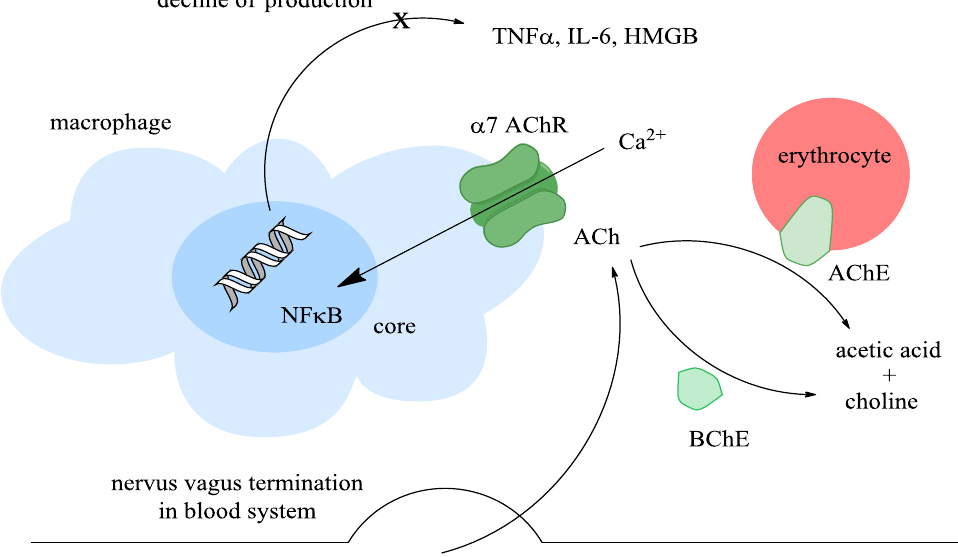
Figure 1. Principle of the cholinergic anti-inflammatory pathway; abbreviations: ACh-acetylcholine; AChE-acetylcholinesterase; BChE-butyrylcholinesterase; HMGB-high mobility group box; IL-6-interleukin 6; NFκB-nuclear factor kappa B; TNFα-tumor necrosis factor